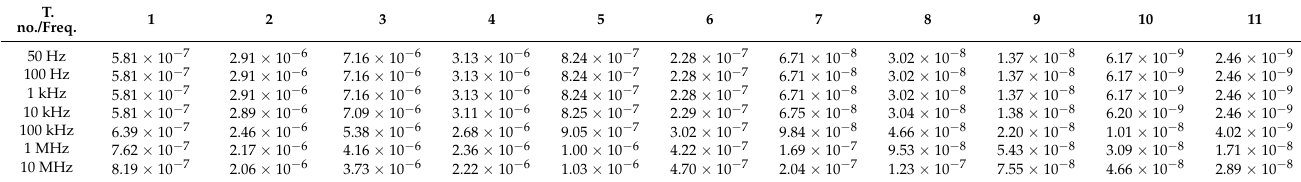
Table A2. Self and mutual inductances of turn 11 (in H) resulting from FEM simulations. T. no./Freq.